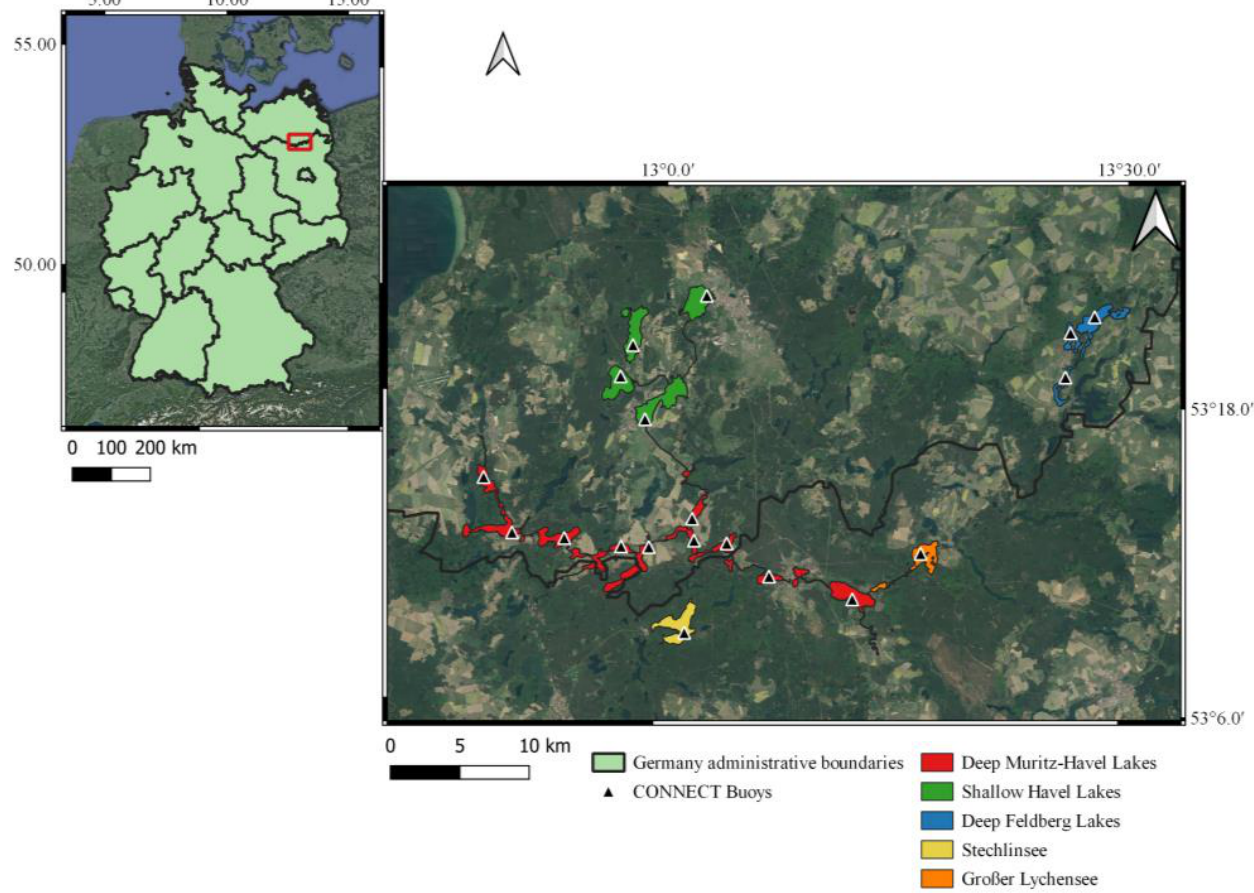
Figure 1. Map of the lakes sampled in this study in the North German Lowland. Colors indicate the lake chain (or nonconnected lakes) and triangles indicate the sampling point in each lake.